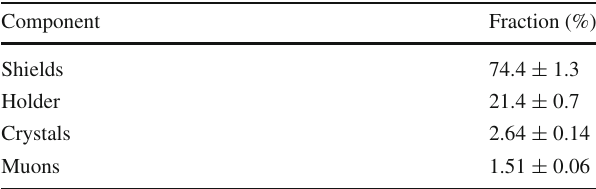
Table 1 List of the background sources contributing to the 0 νββ decay ROI of the CUORE-0 experiment (from [42]). The continuum event rate in this region (i.e. excluding the 60 Co sum peak) is 0 . 058 ± 0 . 006 counts/keV/kg/year) [27]. Column (2) reports the fractional con- tribution of the different sources, as obtained by the CUORE-0 back- ground reconstruction. The Holder is the structure that held the crys- tals, made from CuNOSV and reproduced identically in CUORE. The Shields represent both the cryostat external and internal shields used in CUORE-0 to shield the detector from environmental and setup radioac- tivity (see [42] for more